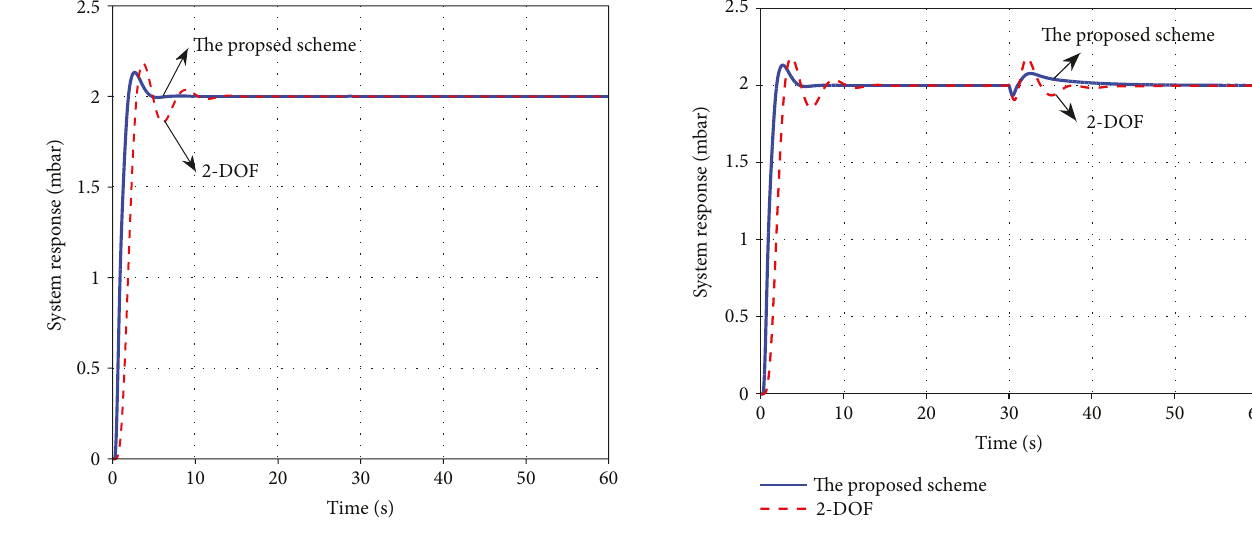
Figure 12: System response comparison with ramp